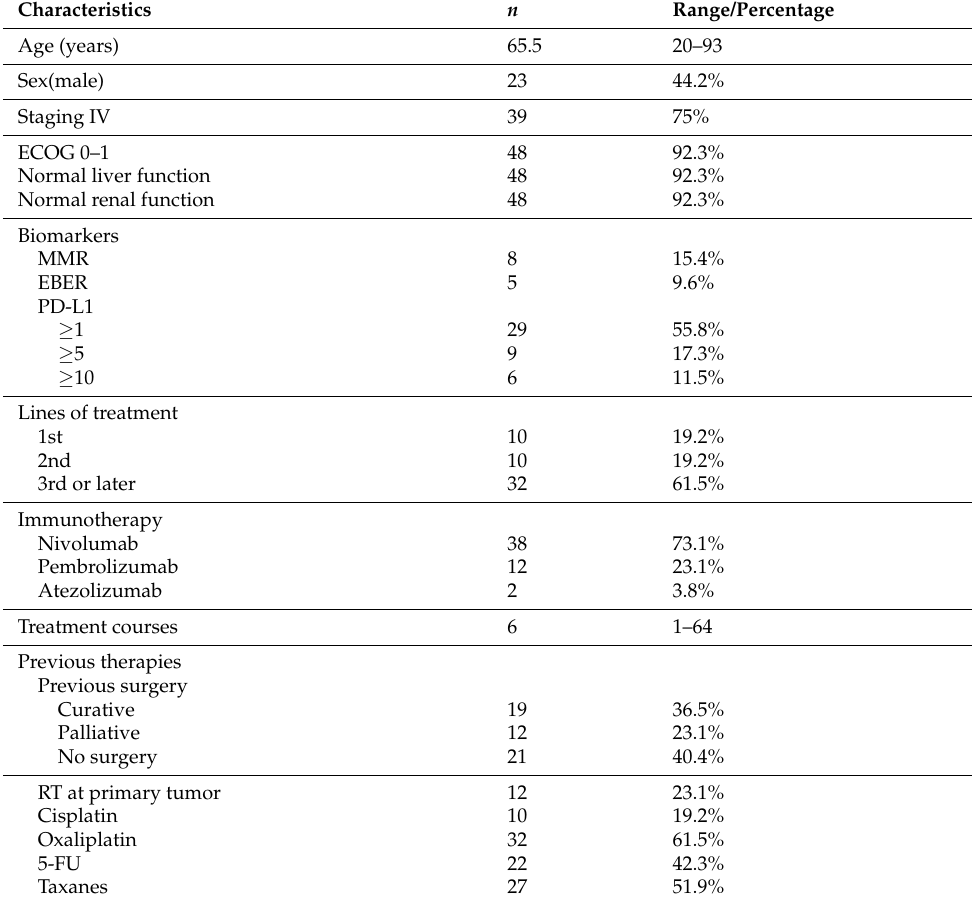
Table 1. Patient